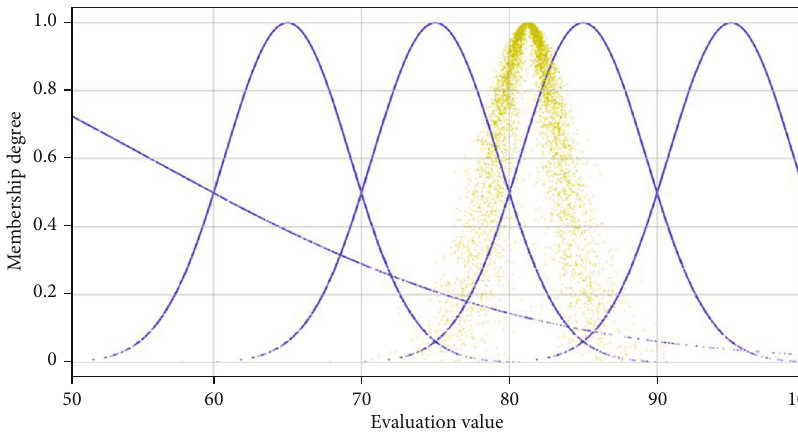
Figure 5: Assessment cloud of coal seam conditions (C11). Table 3: Three-level indicators and membership degree of evaluation